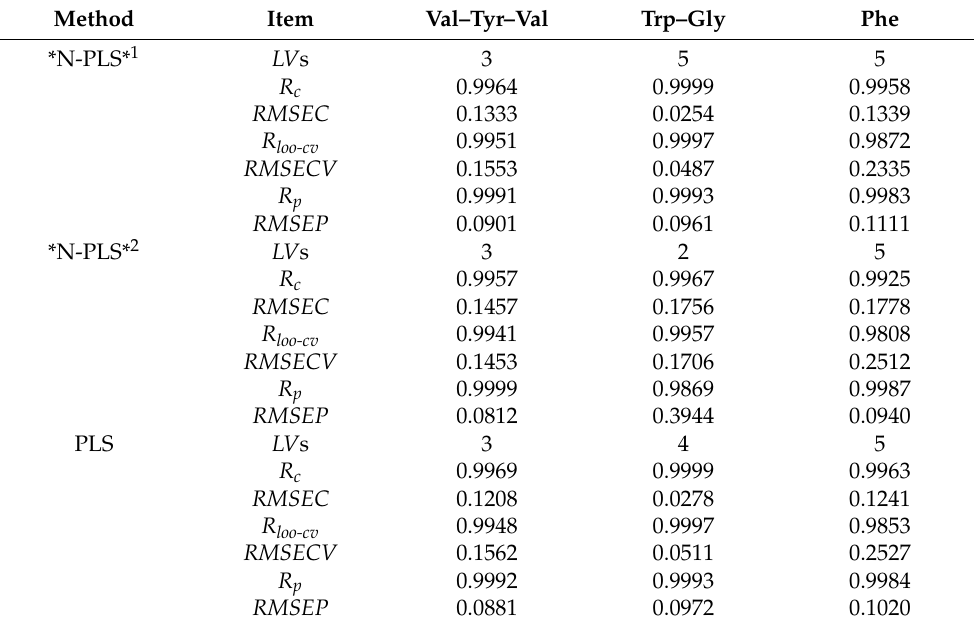
Table 1. The statistical parameters of the N-PLS models using the new constructed 3D EEM spectra, the N-PLS models using the original EEM spectra, and the PLS models using the extracted maximum spectra in the concatenated mode of Data Set